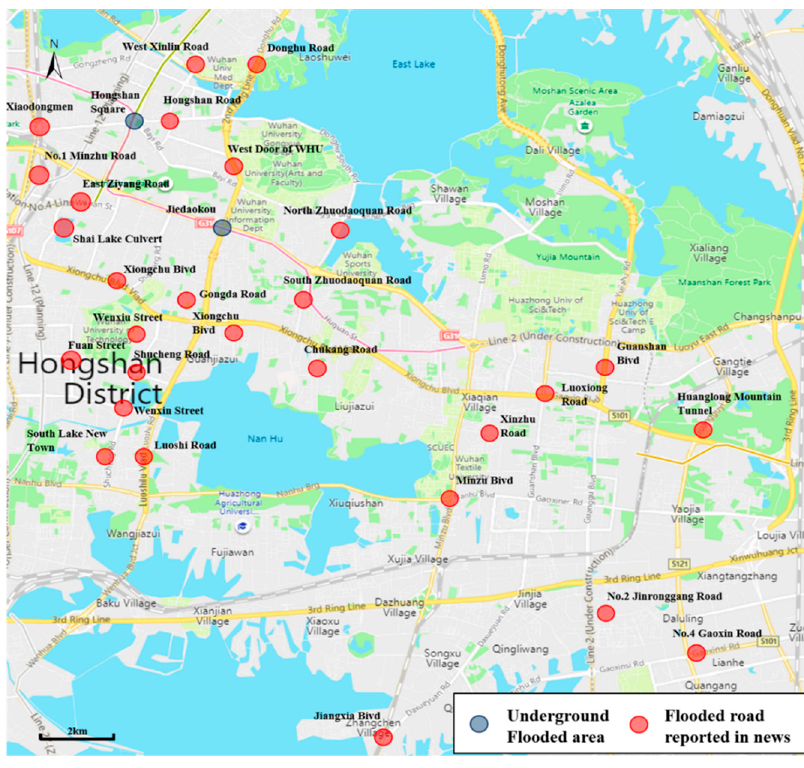
Figure 8. The 30 real flooded roads and areas as reported in the news.